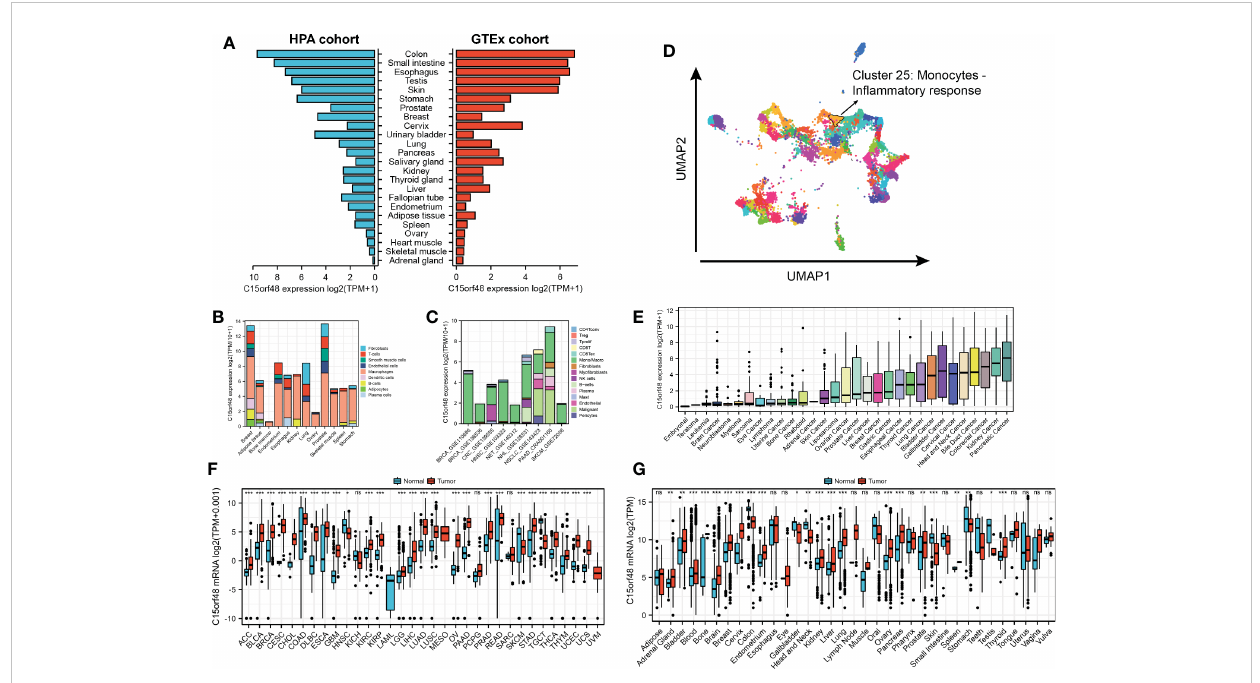
FIGURE 1 (A) Expression level of C15orf48 in normal tissues (HPA+GTEx datasets); (B) C15orf48 expression levels in single cells (HPA datasets); (C) C15orf48 expression levels in single cells (TISCH datasets); (D) C15orf48 is part of cluster 25 Monocytes - In fl ammatory response; (E) Expression levels of C15orf48 in cancer cell lines (CCLE datasets); (F) Differences in the expression of C15orf48 between normal and cancerous tissues (TCGA+GTEx datasets); (G) Differences in the expression of C15orf48 between normal and cancerous tissues (GEO datasets). *p < 0.05; **p < 0.01; ***p < 0.001; NS, No Signi fi